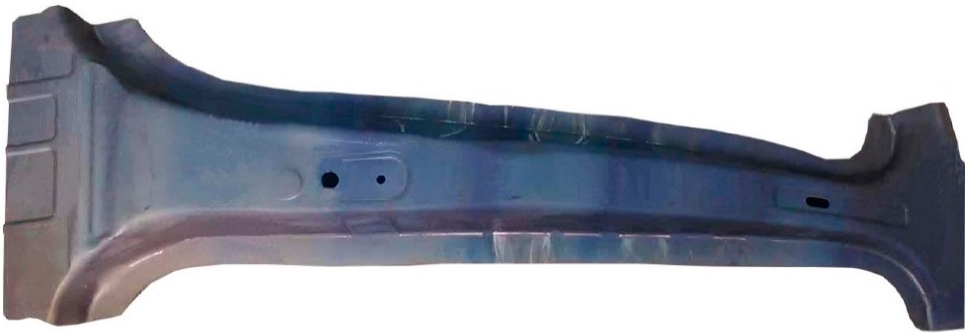
Figure 16. Hot stamping parts of the B ‐ pillar.